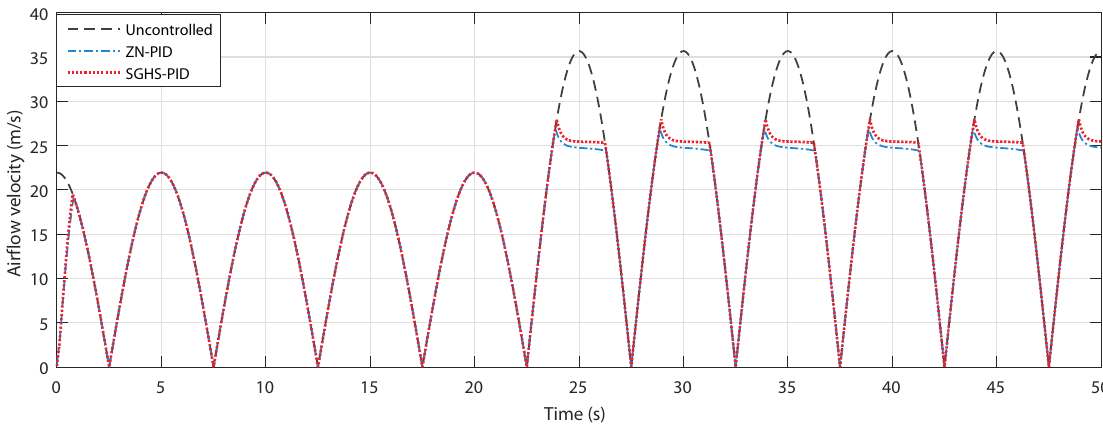
Figure 15. Airflow speed in uncontrolled and controlled cases.